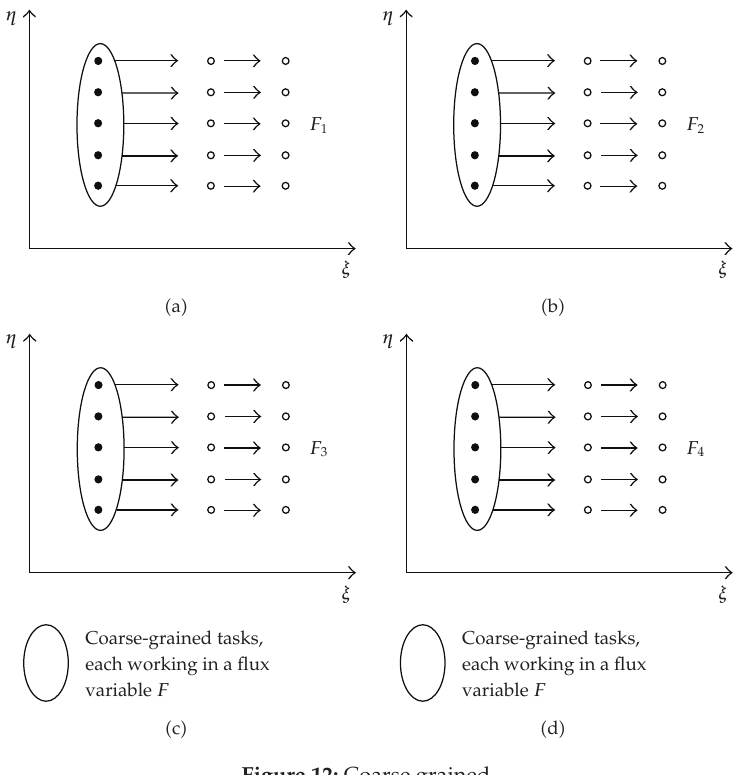
Figure 12: Coarse